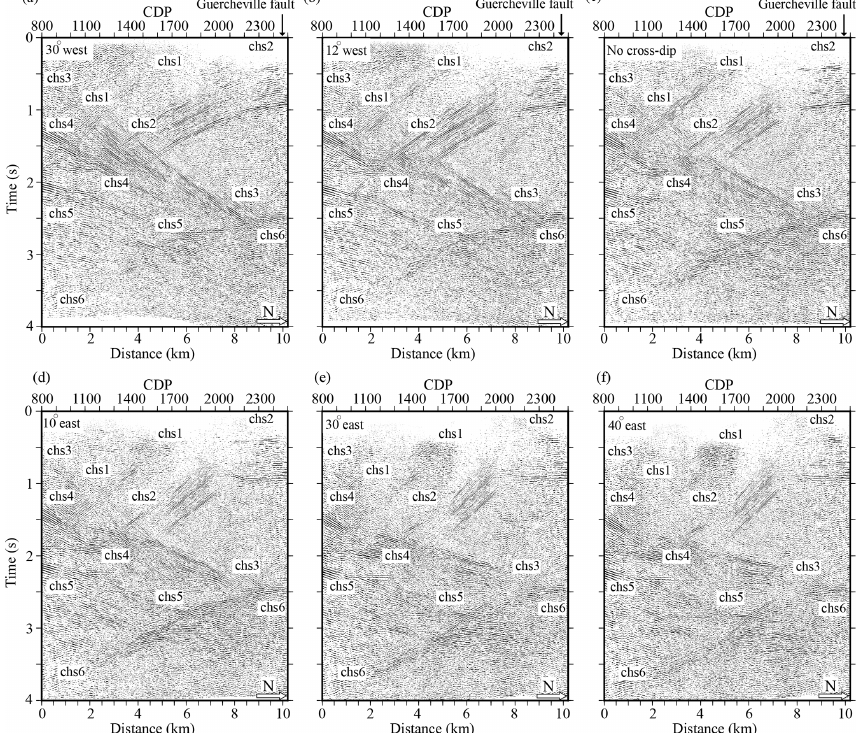
Figure 9. CDMO analysis for a part of the south survey around the Guercheville fault. (see Fig. 4 for the location). (a) DMO-corrected stacked section with cross-dip element of 30 ◦ to the west applied. (b) DMO-corrected stacked section with cross-dip element of 12 ◦ to the west applied. (c) DMO-corrected stacked section with no cross-dip element applied. (d) DMO-corrected stacked section with cross-dip element of 10 ◦ to the east applied. (e) DMO-corrected stacked section with cross-dip element of 30 ◦ to the east applied. (f) DMO-corrected stacked section with cross-dip element of 40 ◦ to the east applied. The surface location of the Guercheville fault is shown at the top of the section. See text for the interpretation of marked